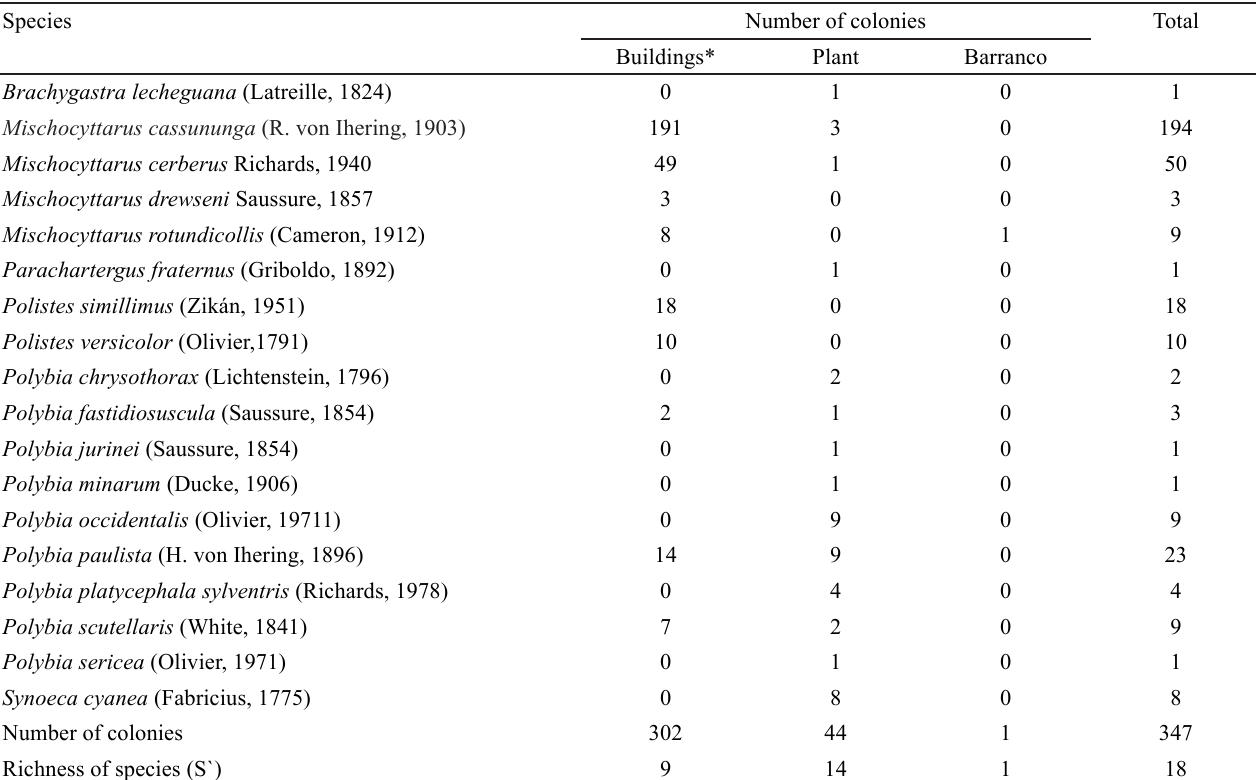
Table 1 . List of social wasp species and number of colonies recorded in urban fragments in the municipality of Inconfidentes, Minas Gerais, Brazil, in the period from March to September of